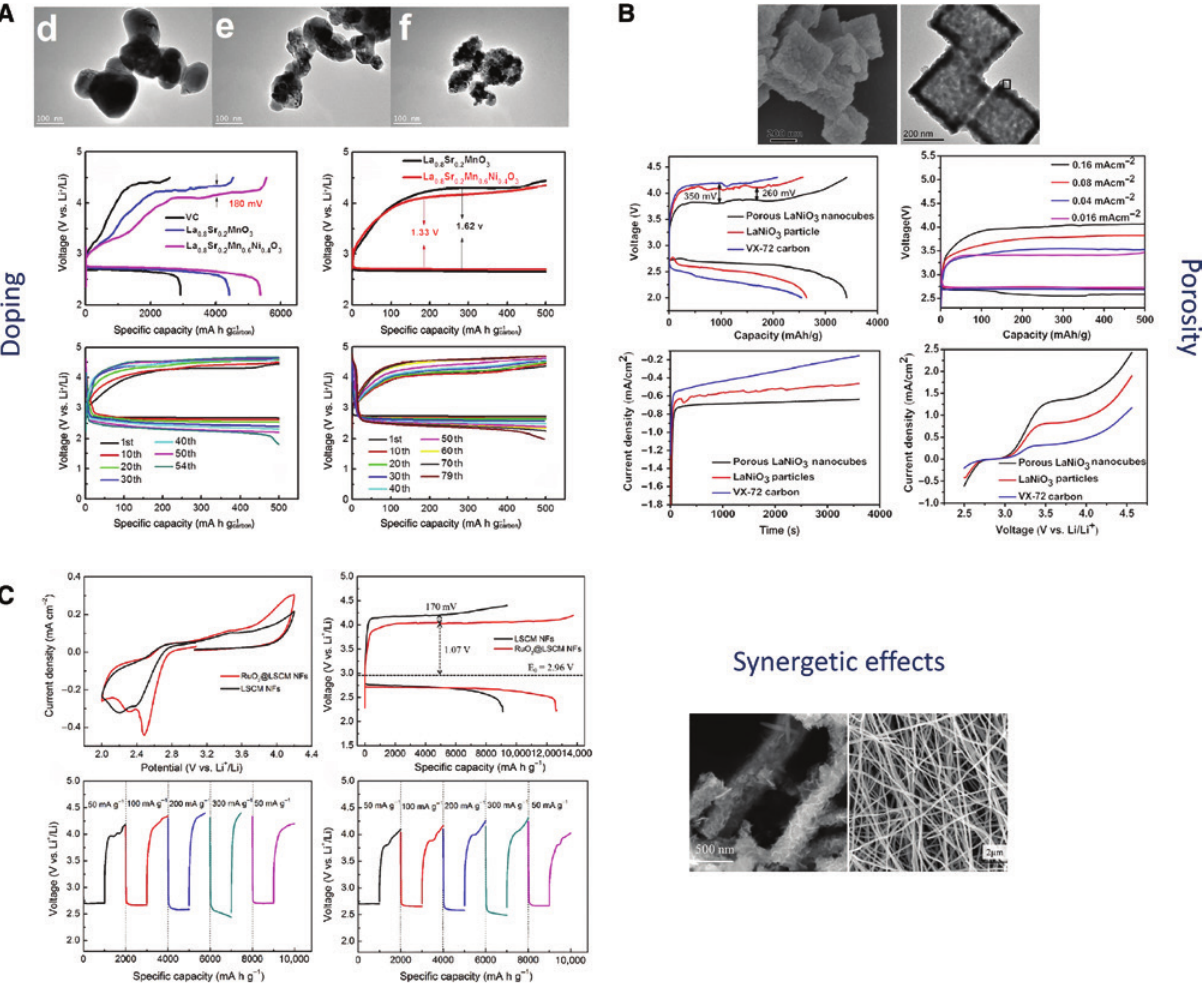
Figure 9: Electrochemical performance of Li-air batteries including perovskite oxide nanocrystals. Three factors that affect this performance are: Ni-doping in manganite perovskite oxide (A), porosity of the nanocrystals (LaNiO nanocrystals (La Sr Co Mn O nanofibers loaded with RuO 0.6 0.4 0.8 0.2 3 (A) Reprinted with permission from [252]. Copyright (2016), American Chemical Society. (B) Reproduced with permission from